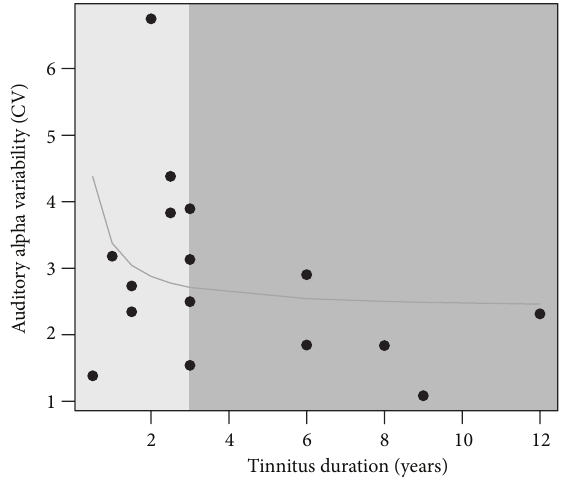
Figure 5: Association between tinnitus duration and alpha variabil- ity. Patients with a longer duration of tinnitus show lower levels of auditory alpha variability (8–10Hz). A median split was calculated andrevealedsignificantdifferenceinthevariabilitybetweenpatients with a long and a short duration of tinnitus with 𝑃 = 0.038